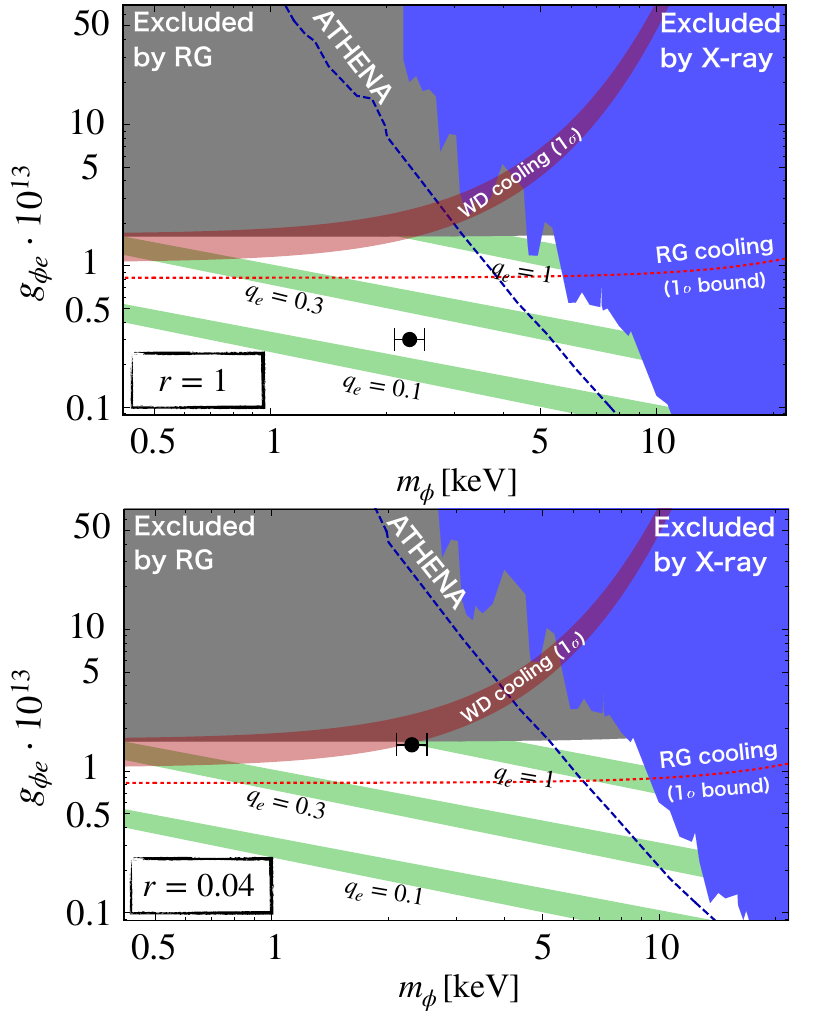
Figure 3 . The mass and coupling to electrons suggested by the XENON1T excess are shown by black dots for r = 1 (upper panel) and r = 0 . 04 (lower panel). The predicted relation for g φe and m φ in the ALP inflation is shown as green bands for q e = 1 , 0 . 3 , and 0 . 1 from top to bottom. The X-ray bound for anomaly-free ALP DM [3, 17] is shown by the blue shaded region. The future sensitivity of ATHENA is shown by the blue dashed line [50, 51]. The red shaded region is preferred by the cooling of white dwarf stars. The gray region and the red dashed line represent the bound from the cooling of the tip of the red-giant branch [25] at 2 σ and 1 σ level,